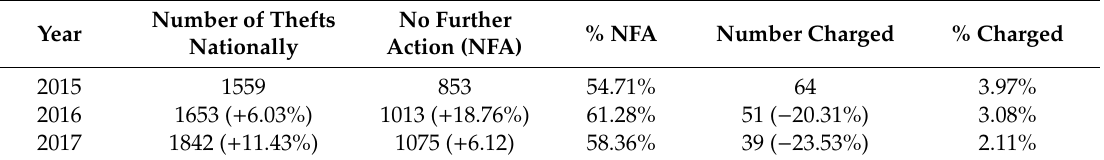
Table 5. Number of dog thefts nationally and the number of outcomes in terms of no further action and